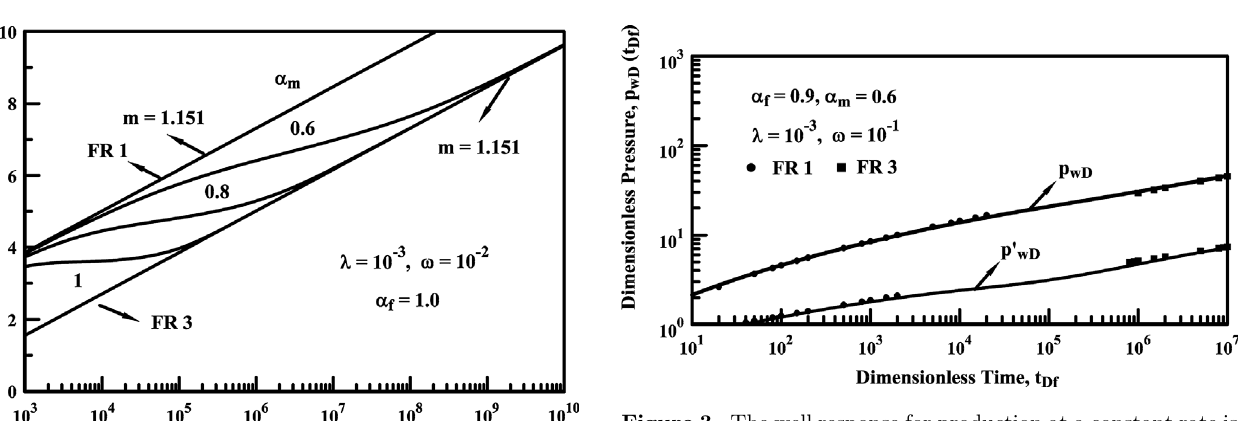
Figure 3. The well response for production at a constant rate is considered; the top and bottom curves, respectively, are the dimensionless pressure responses, p wD , and the corresponding logarithmic derivatives, p 0 . The circles and squares are the wD analytical responses corresponding to Flow Regimes 1 and 3, respectively. Flow Regime 2 is essentially absent.